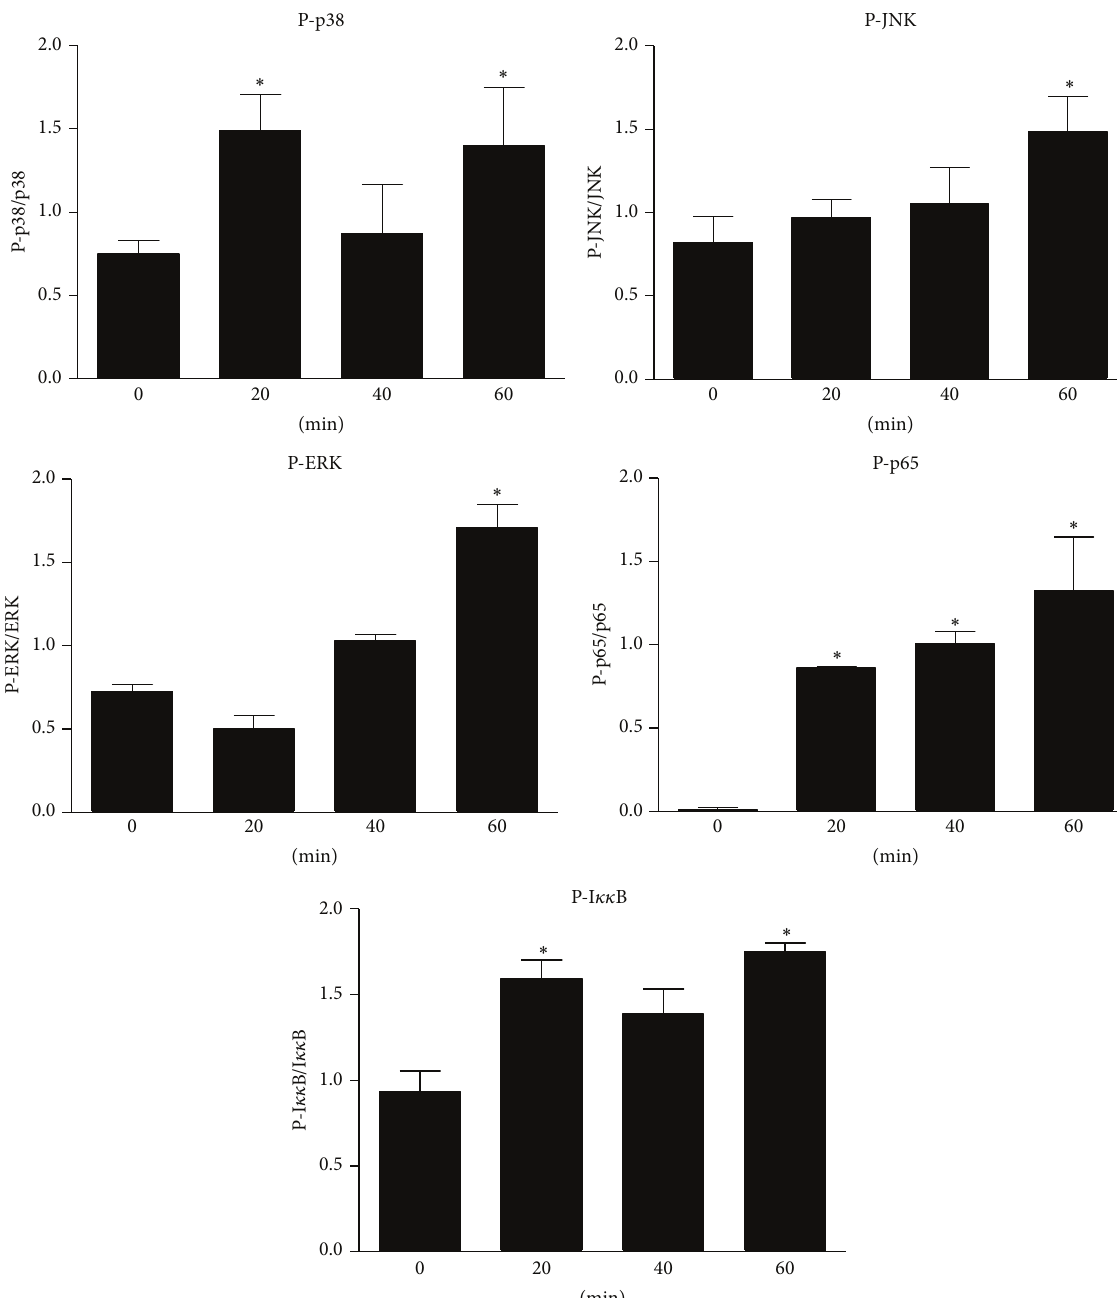
Figure 6: Effect of IL-29 on the phosphorylation of Jak-STAT, AKT, MAPK, and NF- 𝜅 B signaling pathways. OA FLS were treated with IL-29 at 100 ng/mL for 0 , 20, 40, and 60 min, and the activation of STAT 1/2/3/4/5/6, AKT, JNK, ERK, P38, p65, and NF- 𝜅 B was evaluated by western blot. The relative quantification of target proteins was calculated by comparison of the bands density levels between samples. The results were expressed as mean ± SEM from three independent experiments. ∗ 𝑃 < 0.05 versus nontreatment